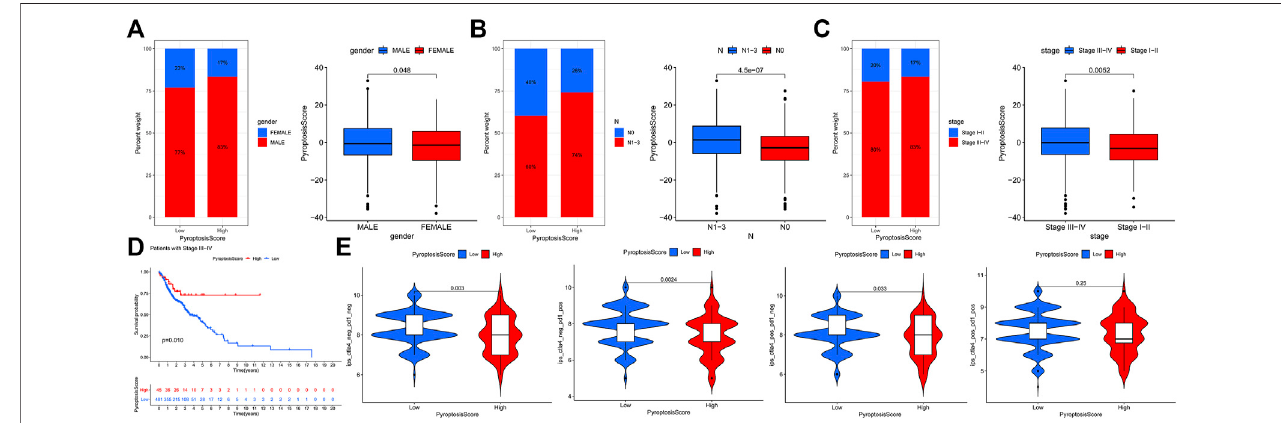
FIGURE6| RelationshipbetweentheclinicalcharacteristicsandPyroptosisScore. (A) .Gender, (B) .Nstage,and (C) .tumorstage. (D) .Highscoregroupmeansa bad prognosisinstageIII-IVpatients. (E) .Immunophenoscore(IPS)functionisbasedonThe Cancer Immunome Atlasdatabasetopredicttheresponsivenessto CTLA- 4 and PD-1